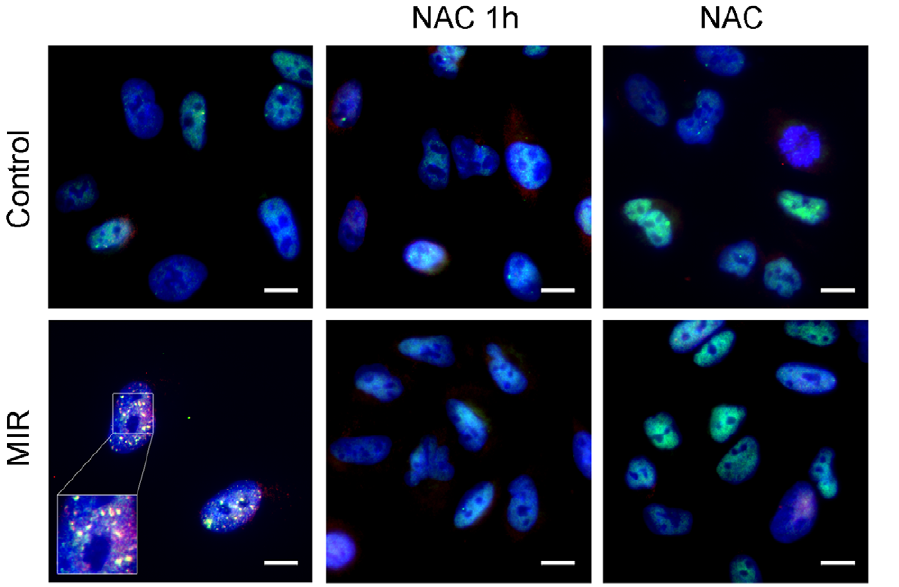
Figure 6. Effect of MIR exposure on DNA double strain breaks in A549 cells. Cells were seeded onto the glass coverslip in 12-well plate, exposure by MIR for 48 hours in the presence or absence of 10 mM N-Acetyl-Cysteine (NAC). Cells were treated with NAC for 1 h prior to MIR exposure (NAC 1 h) or cotreated throughout the exposure for 48 h (NAC). Cells were fixed for staining and visualized by fluorescence microscopy. 53BP1 was labeled with rabbit anti-53BP1 antibody and corresponded FITC–conjugated anti-rabbit IgG antibody (green), c -H2AX was labeled with mouse anti- c -H2AX antibody following corresponded PE–conjugated anti-mouse IgG antibody (red), and nuclei were labeled with DAPI (blue). Scale bar represents 10 m m.